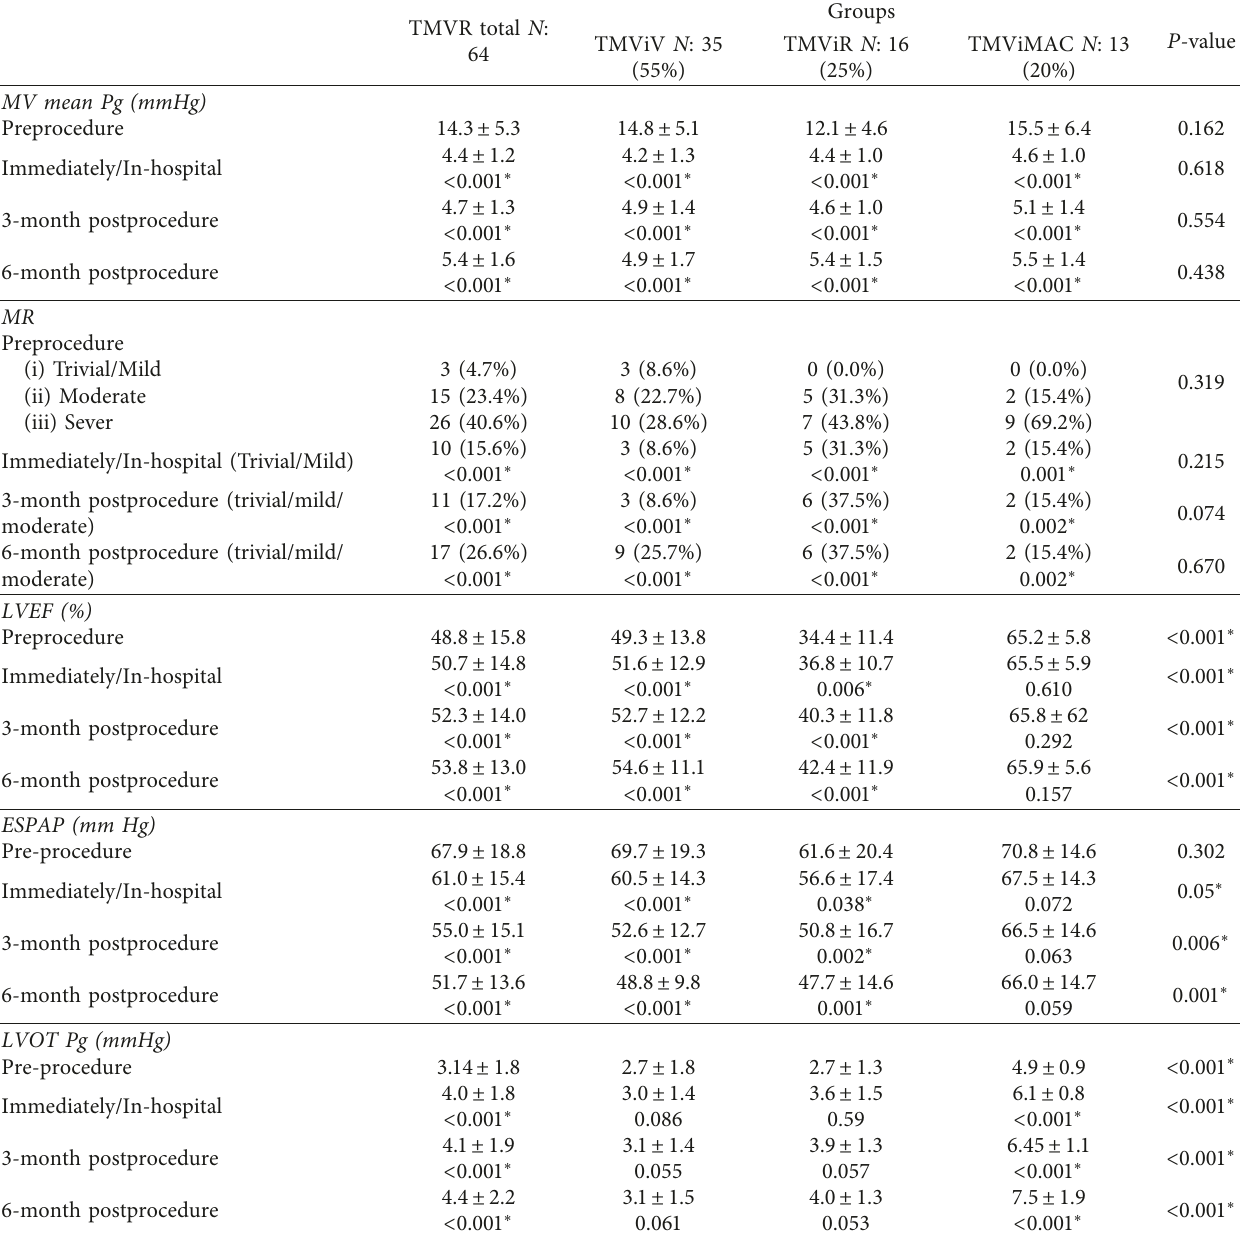
Table 3: Echocardiographic assessments of valvular function throughout